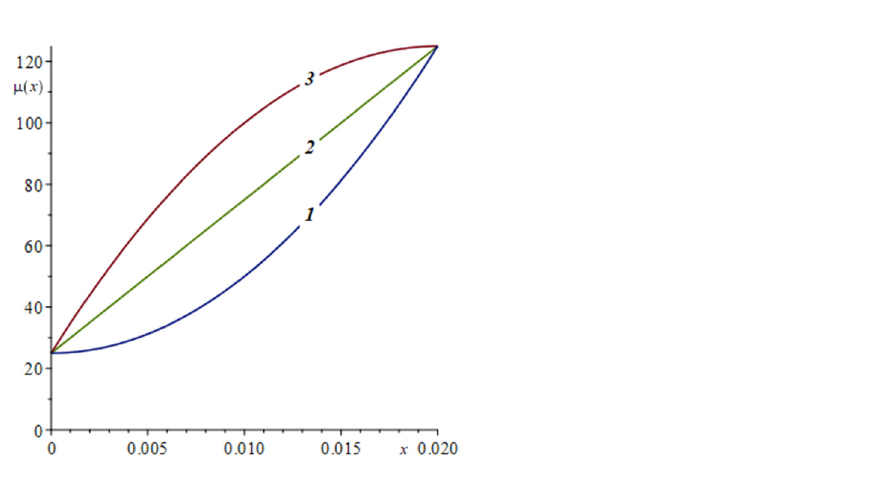
Figure 5. Variation of the shear modulus µ ( x ) by the coating depth at the considered values of µ 1/2 : 1 —50, 2 —75, 3 —100 GPa.